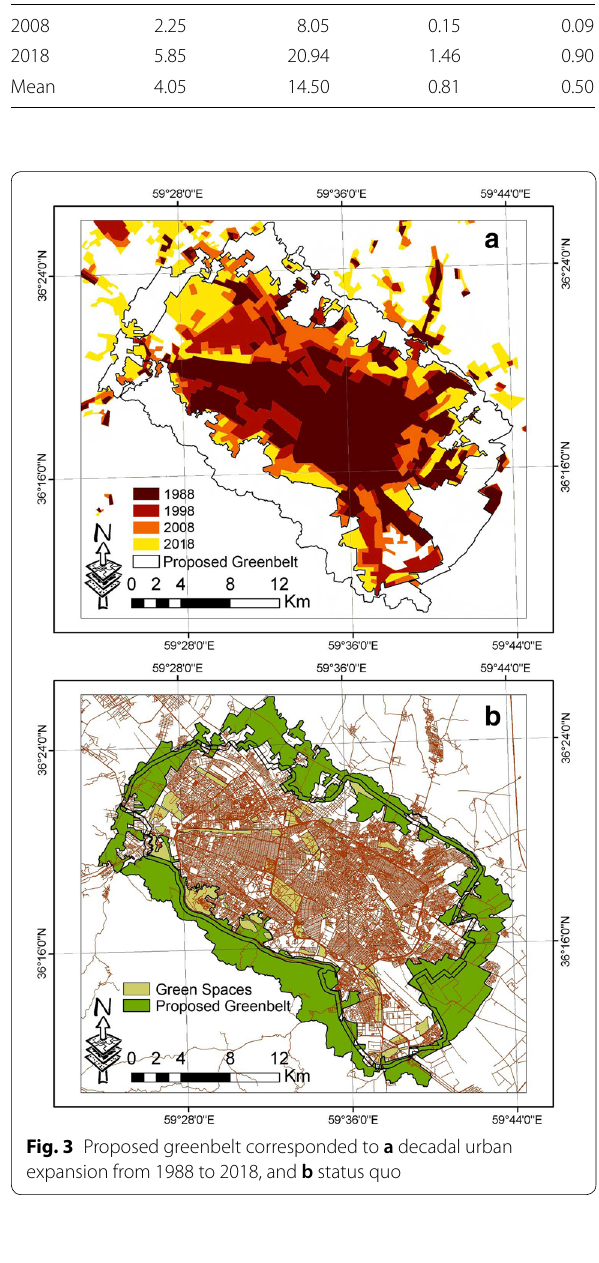
Fig. 3 Proposed greenbelt corresponded to a decadal urban expansion from 1988 to 2018, and b status